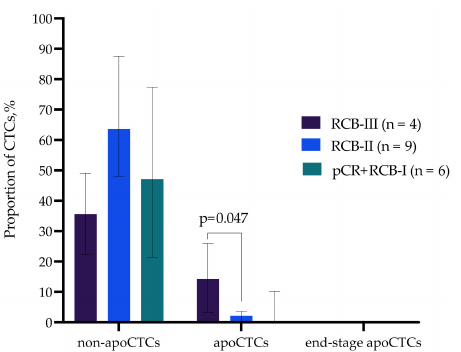
Figure 5. Proportion of non-apoCTCs, apoCTCs and end-stage apoCTCs in breast cancer patients with different responses to neoadjuvant